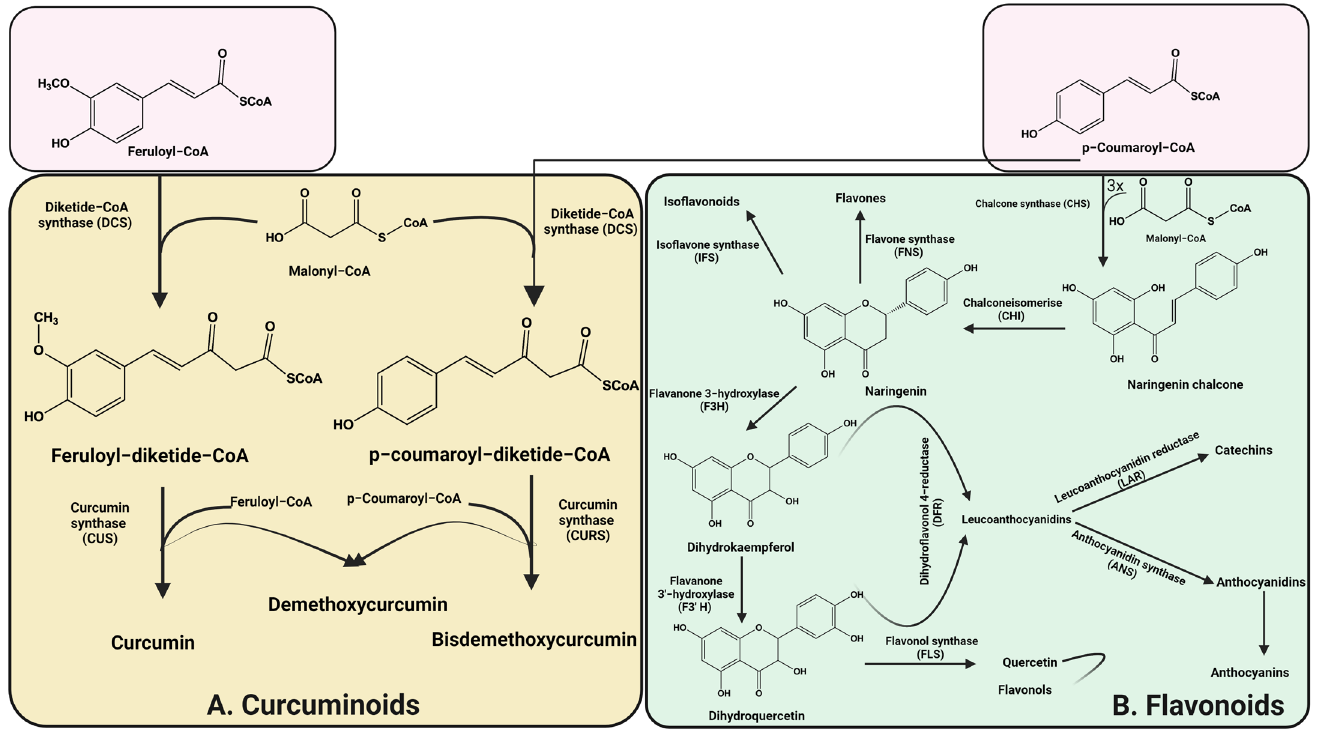
Figure 2. Biosynthesis pathways of flavonoids and curcuminoids.